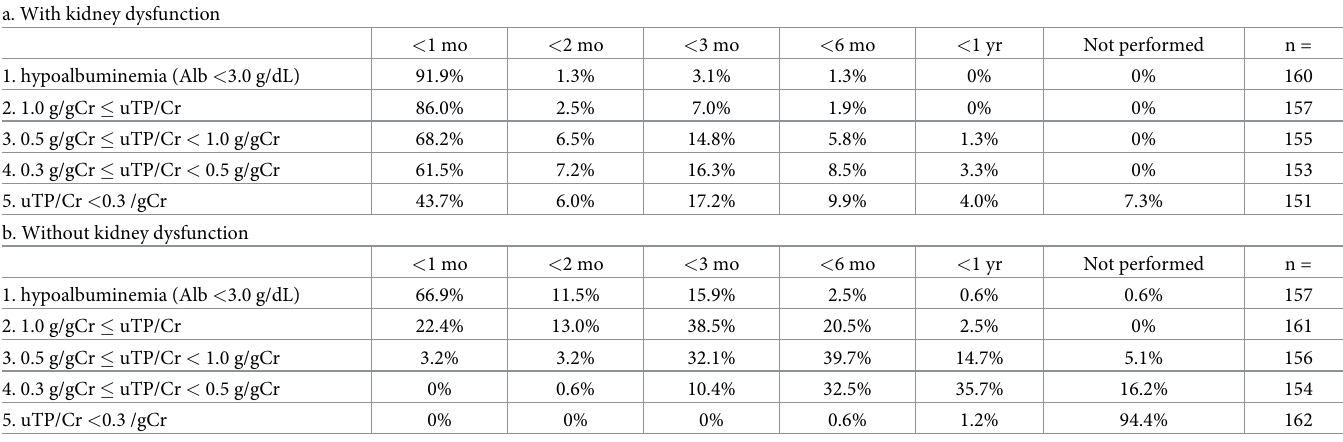
Table 1. Indications for kidney biopsy and times to biopsy. a. With kidney